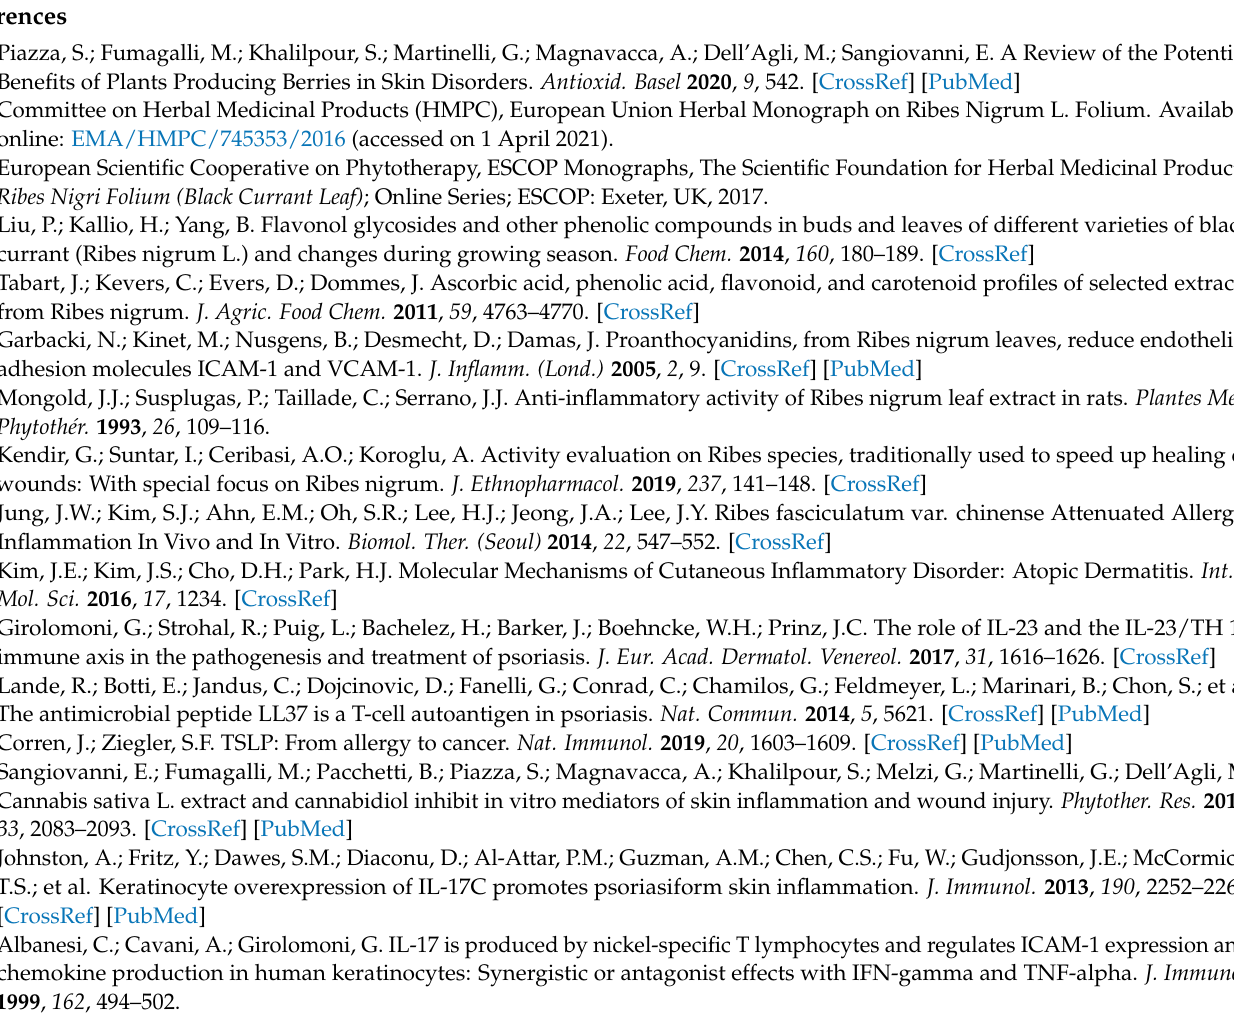
Figure A4. Preliminary time course experiment aimed at assessing IL-6 release from HaCaT cells at different stages of differentiation, stimulated with TNF-α (20 ng/mL), IL-4 (100 ng/mL), or a combination of both.